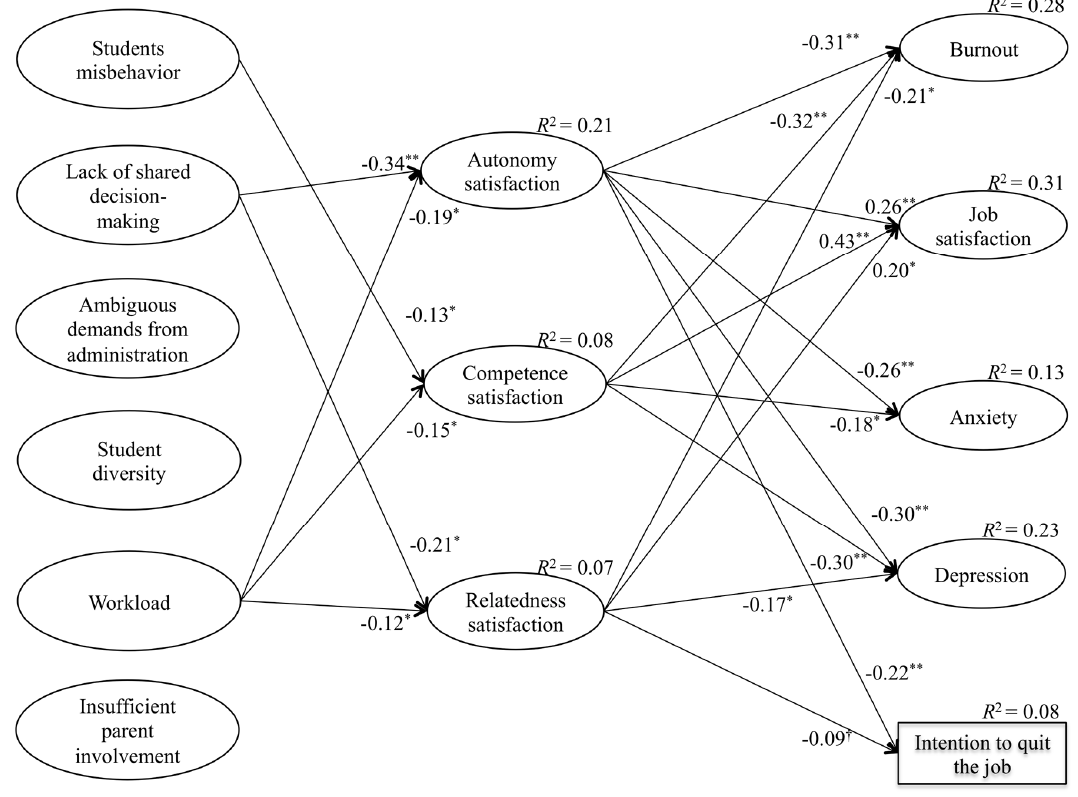
Figure 1. Structural model that relates teachers’ stressors with the satisfaction of the basic psychological needs and teachers’ psychological outcomes. This is a figure, Schemes follow the same formatting. Note. † = p < 0.80. * = p < 0.05. ** = p < 0.01.